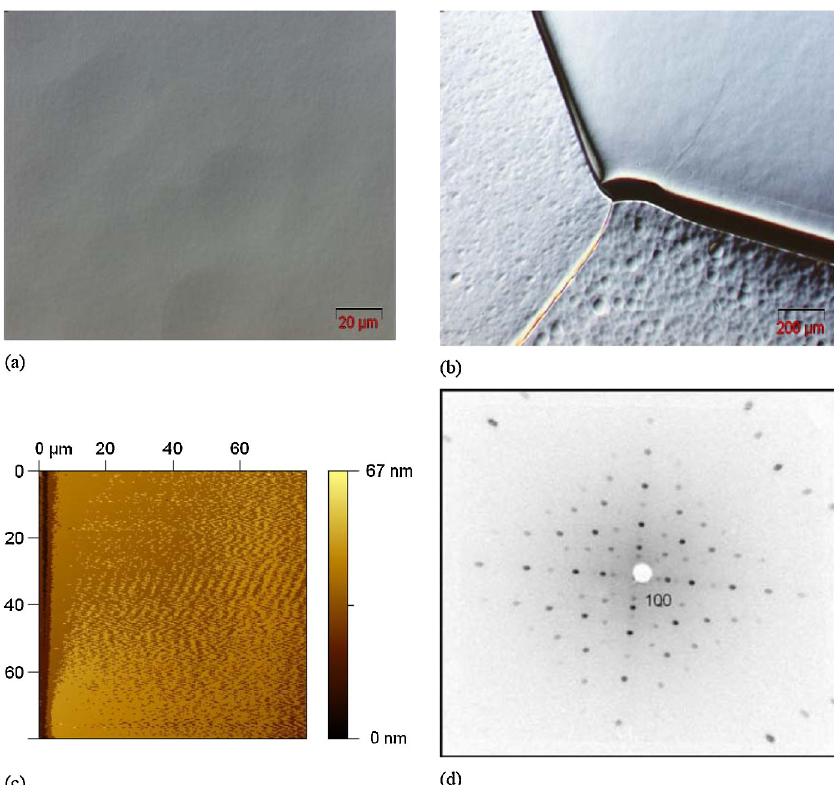
FIG. 1. (Color) (a) High resolution optical microscope image of sample SCNb5, (b) microscopic view of intersection of grain boundaries on large grain sample LGNb3, (c) AFM image of sample SCNb5 showing root mean square roughness of 7.5 nm over ð 80 (cid:5) 80 Þ (cid:1) m 2 area, and (d) XRD image of SCNb5 revealing (100)